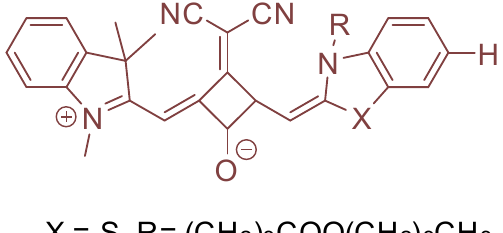
Figure 38. Compound 7f squarine compound by Martin et al.